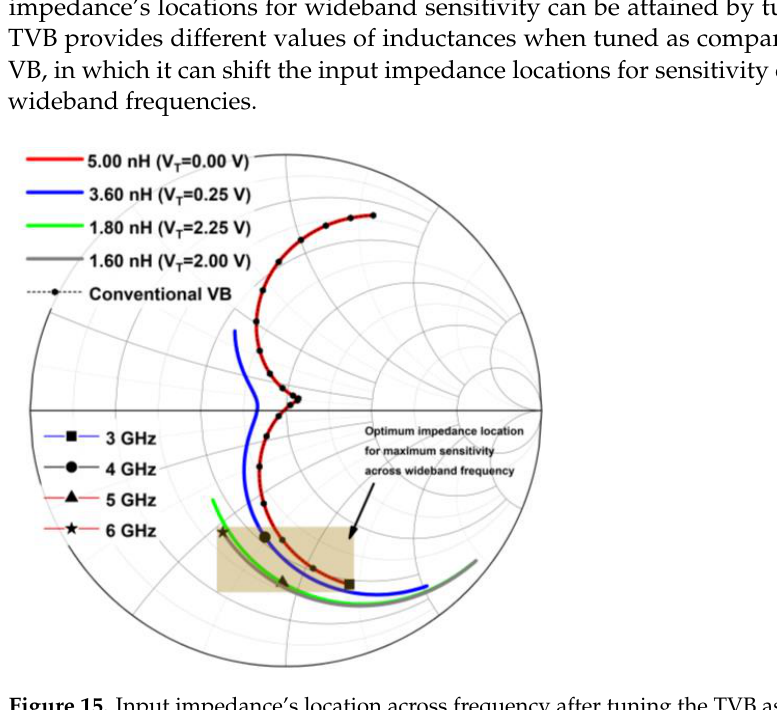
Figure 15. Input impedance ’ s location across frequency after tuning the TVB as compared to con- ventional VB.